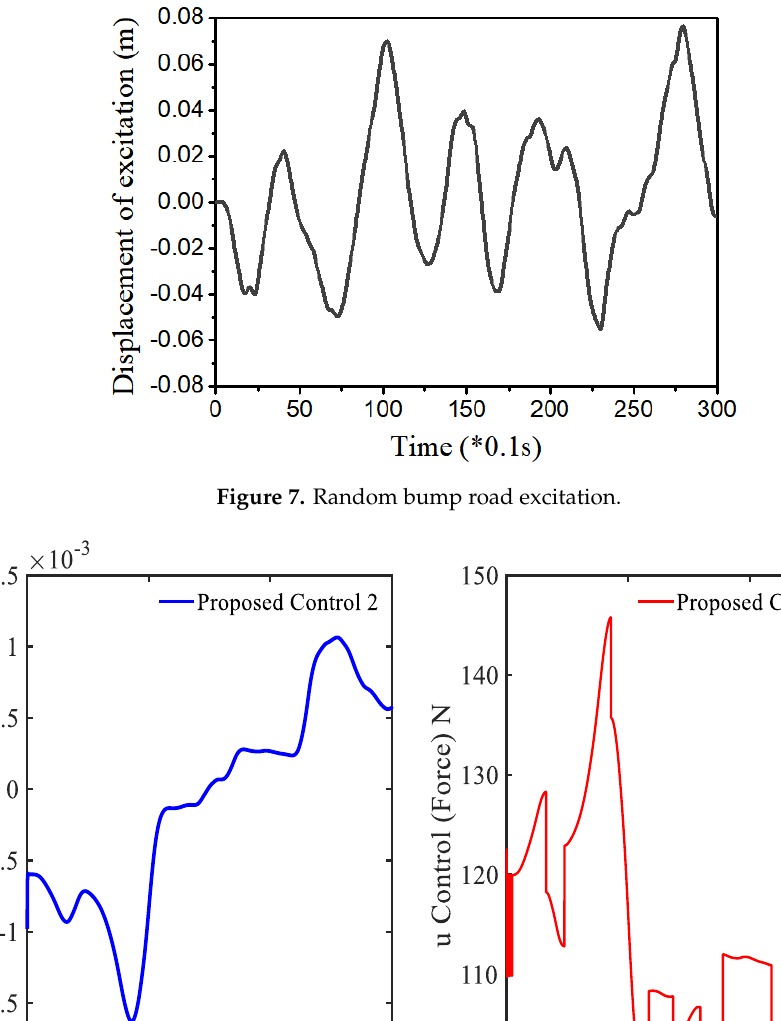
( b ) Figure 9. Vibration control results at the seat position under random bump road excitation: ( a ) displacement, ( b ) velocity.